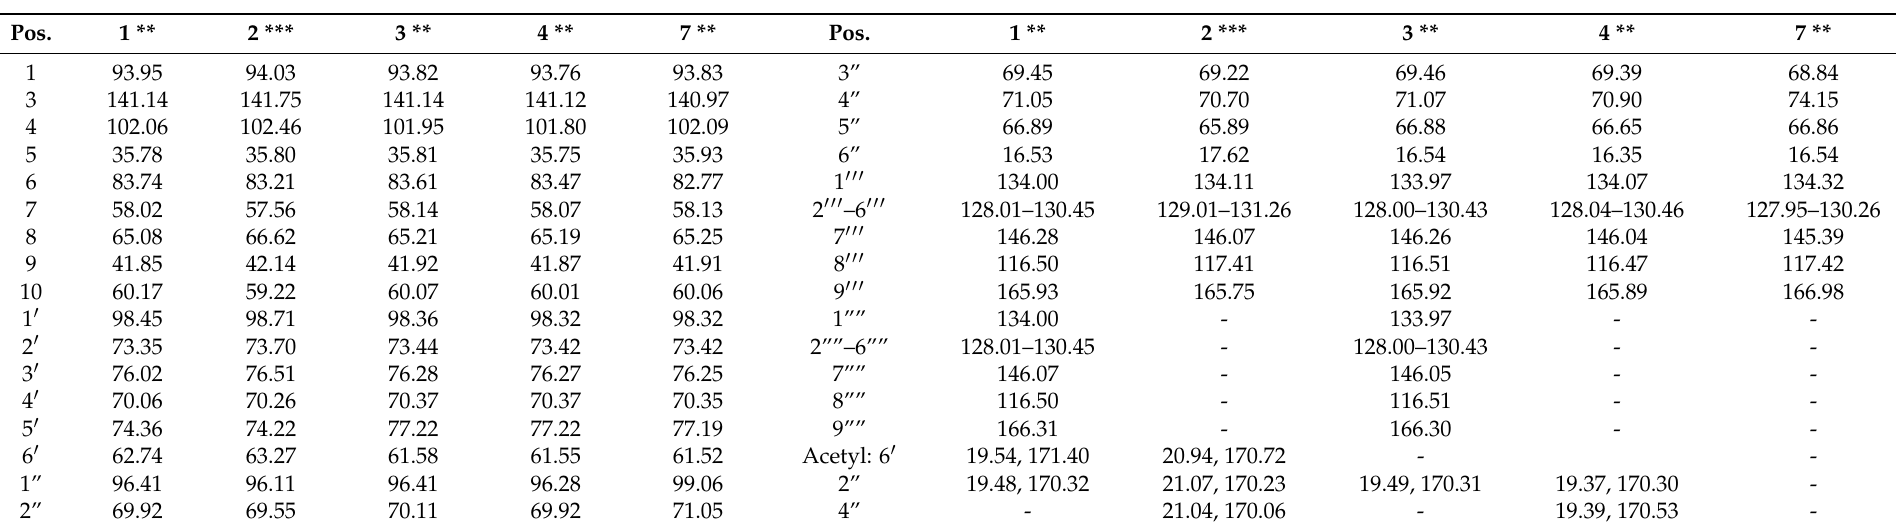
Table 2. 13 C NMR data ( δ ppm) for compounds 1–4 and 7